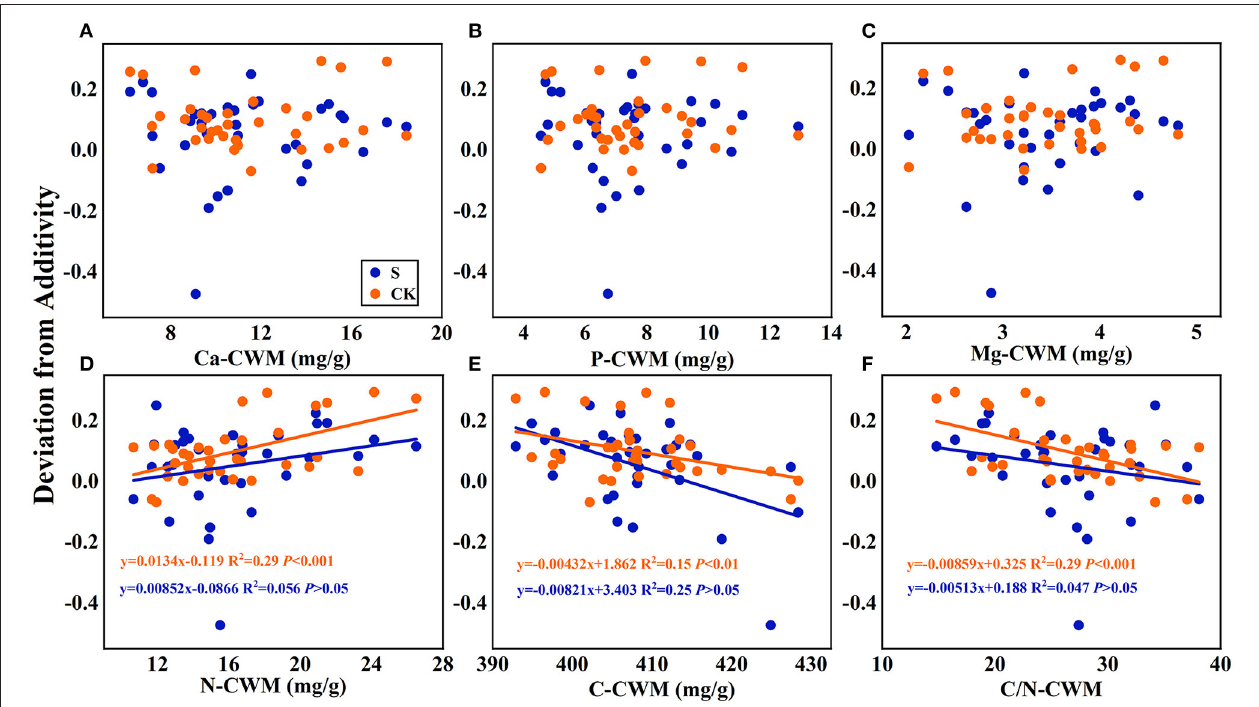
FIGURE 7 | Linear regression relationships (A–F) between the mean mixing effect intensity of litter decomposition and community weighted mean traits (CWM) of litter mixture. S stands for litter that has been decomposed in the submergence environment, and CK stands for litter that has been decomposed in the terrestrial